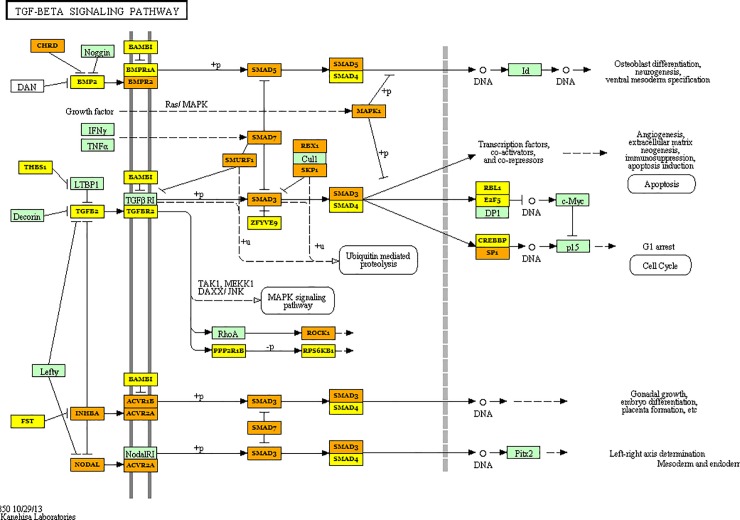
Schematic representation of the TGF-β signaling pathway and the target genes of the microRNAs differentially regulated between tumor tissue and healthy tissue from patients diagnosed with colorectal cancer.Yellow box–target gene of one down-regulated miRNA; Orange box–target gene of two or more down-regulated miRNA.